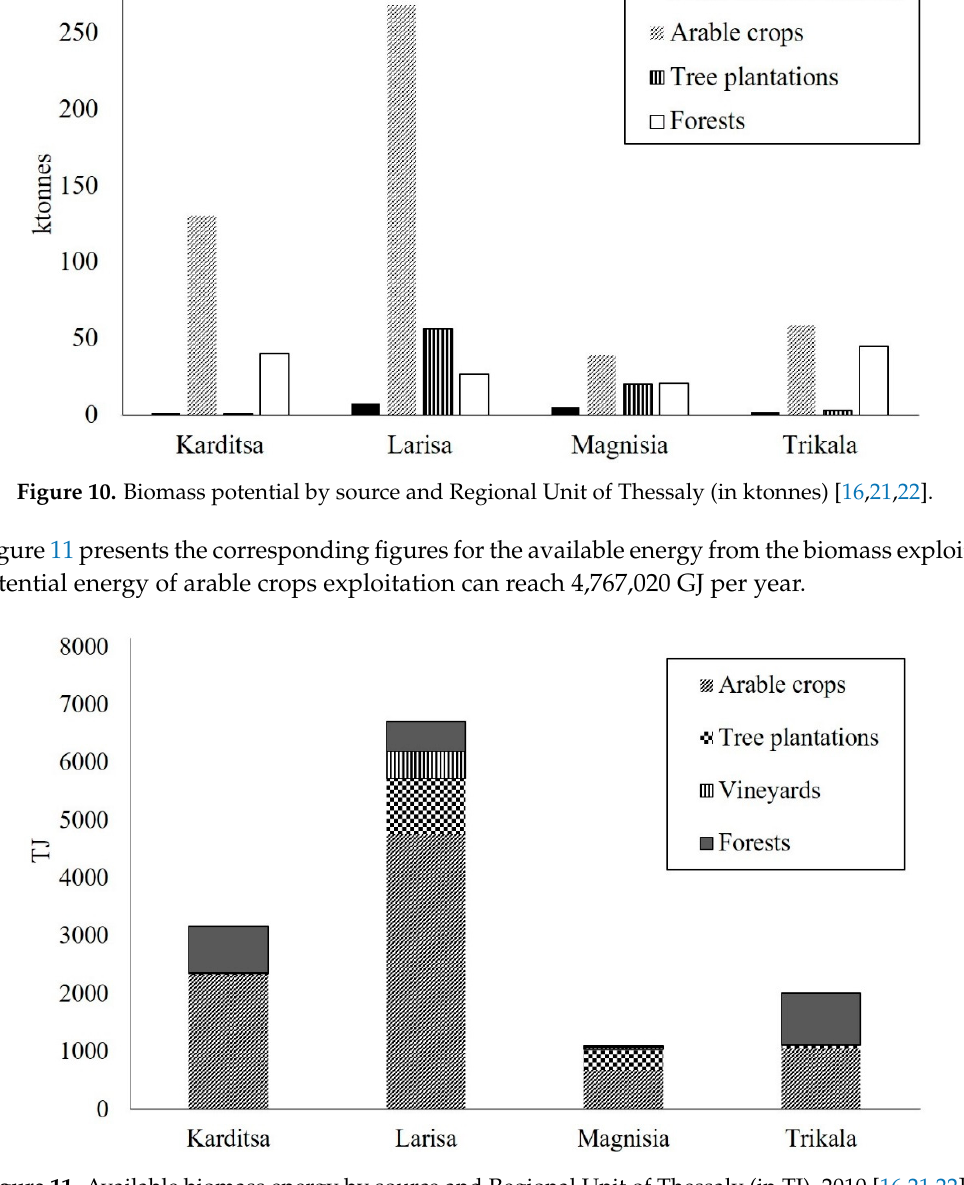
Figure 11. Available biomass energy by source and Regional Unit of Thessaly (in TJ), 2010 [16,21,22].